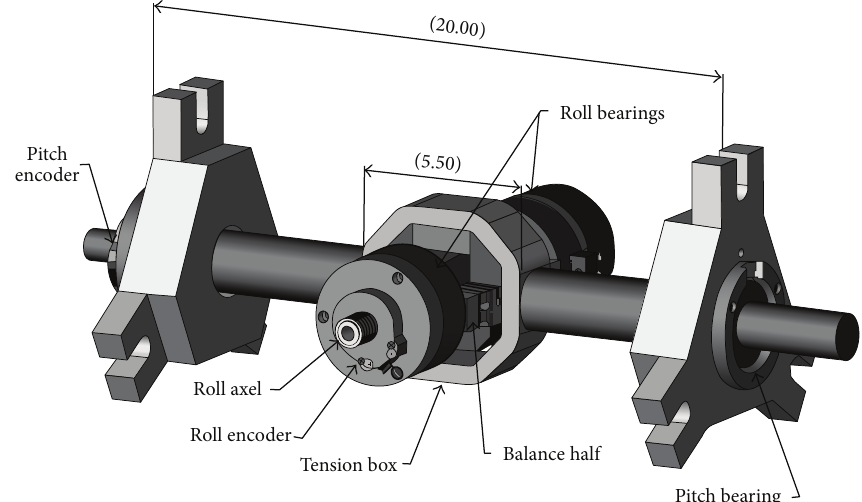
Figure 16: Collar assembly supporting missile fore-and-aft sections and providing free pitch and roll